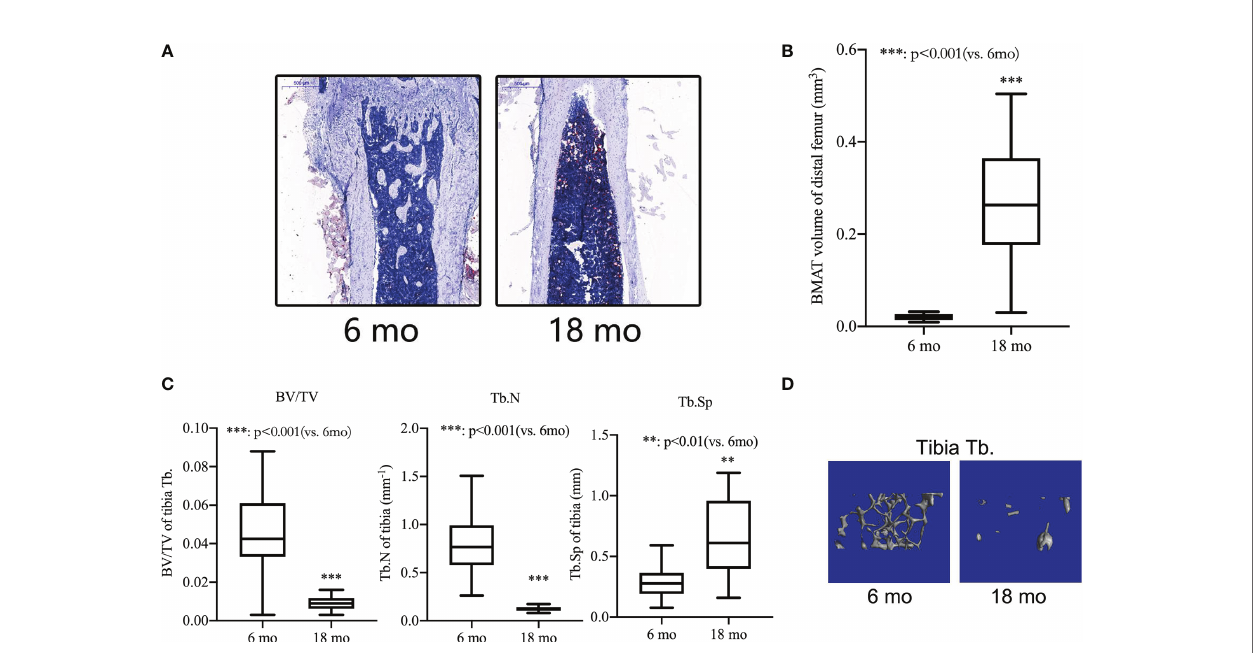
FIGURE 3 | Bone loss and bone marrow adipogenic differentiation in aged mice. (A) Oil red-O stain of the medullary cavity of femur for intra-bone marrow in mice. (B) A morphometric analysis in the volume of bone marrow adipose tissue (BMAT). (C) Bone volume fraction (BV/TV), trabecular bone number (Tb.N) and trabecular bone space (Tb.Sp) of the proximal tibia from 6- and 18-month-old mice were determined by micro-CT. (D) Representative 3D reconstruction images of the proximal tibia Tb. All the data were obtained from three independent experiments. Data are shown as the means ± SEMs. **p < 0.01, ***p < 0.001, 18 mo vs. 6